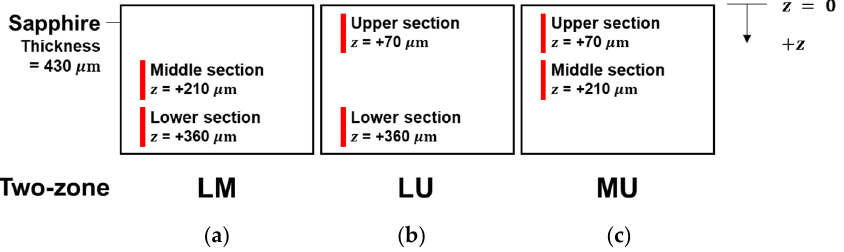
Figure 2. Schematic of two-zone scanning of one-third sections of wafer thickness with middle focus located at the indicated z values for two-zone ( a ) LM (lower-middle sections), ( b ) LU (lower-upper sections), and ( c ) MU (middle-upper sections).